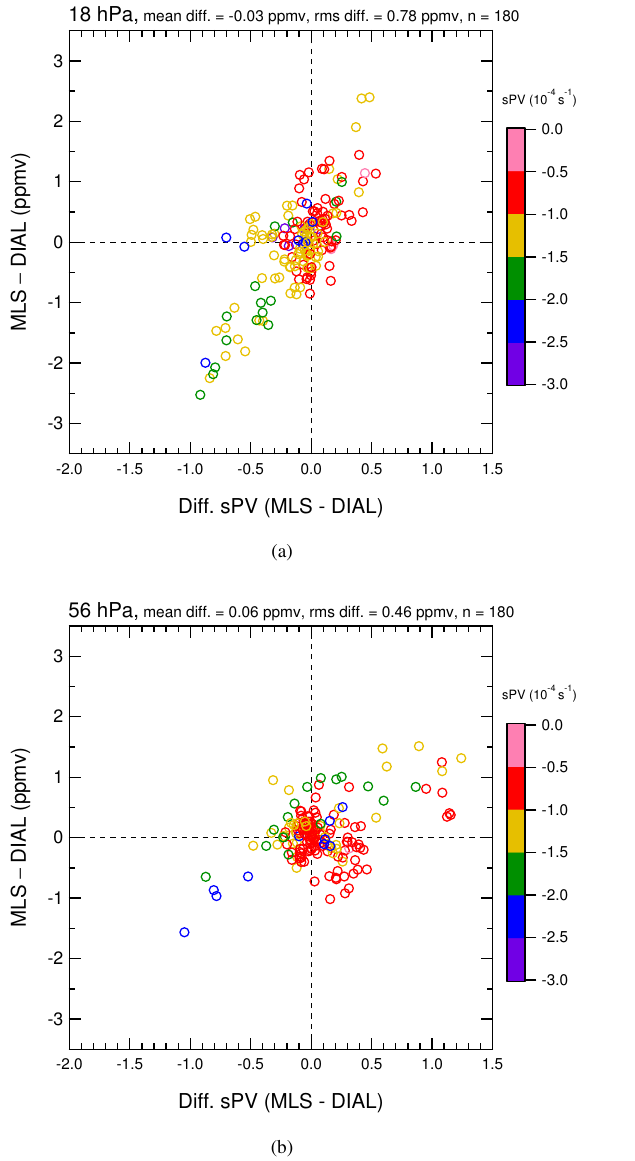
Figure 7. O 3 difference versus sPV difference for DIAL and MLS at 18hPa (a) and 56hPa (b) . Data are color coded based on the sPV for the MLS measurements.